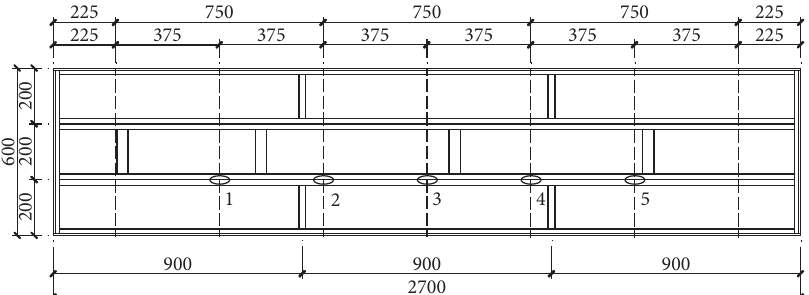
Figure 10: Arrangement of the measuring points of strain on the three-span continuous formwork.